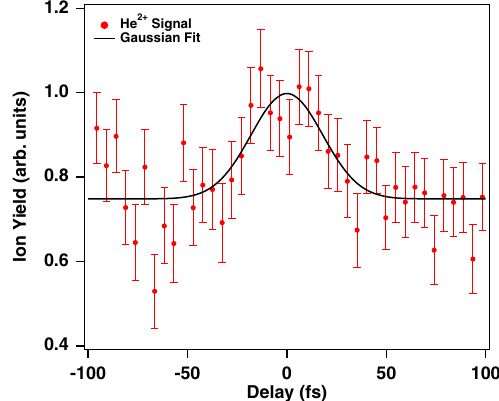
FIG. 9. Autocorrelation signal for helium averaged over all 30 bunches. The figure shows the He 2 þ signal resulting from a two- photon absorption. The fit yields a XUV pulse duration of 30 (cid:3) 6 fs (FWHM). The data were recorded for an XUV wavelength of 24 nm. For each data point, ∼ 80 . 000 XUV pulses were summed.